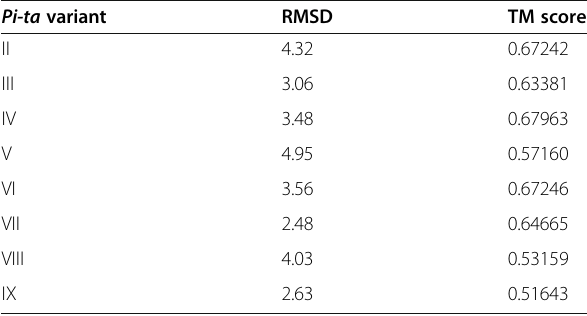
Table 3 The values of root mean square deviation (RMSD) and TM score for superimposed Pi-ta protein variants with wPi-ta Pi-ta variant RMSD